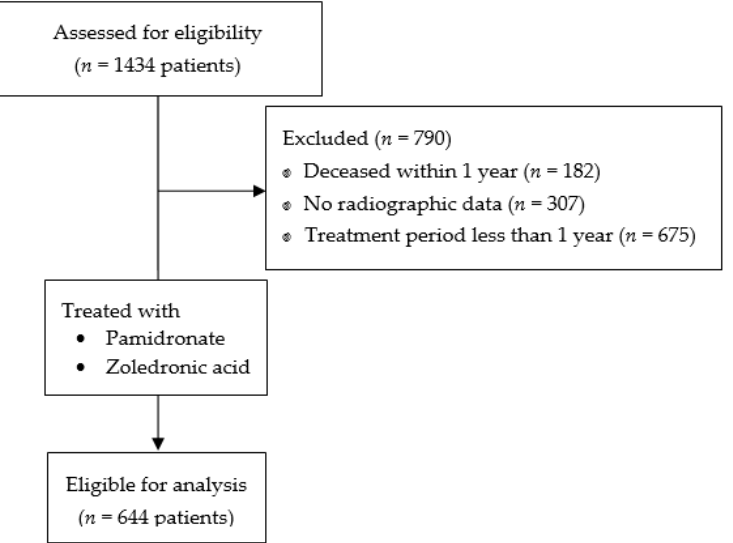
Figure 1. Flow diagram for the determination of the study population for staging system suggested in the 2009, 2014 updated position paper from the American